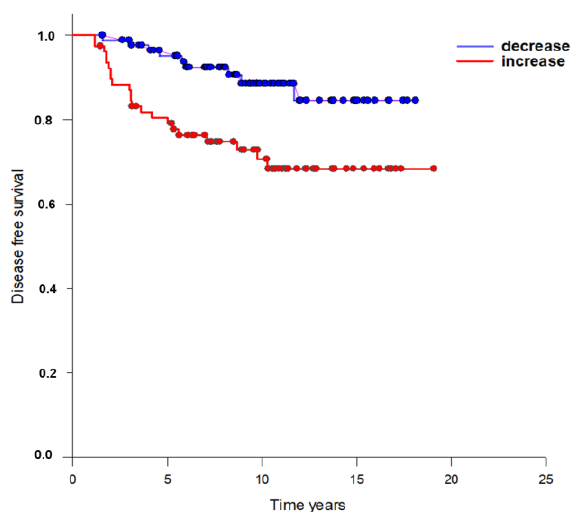
Figure 2. Survival curves based on Kaplan–Meier estimates for patients with early-stage breast cancer who had increased (blue) or decreased (red) numbers of CETC/CTC in the course of RT ( p = 0.003).